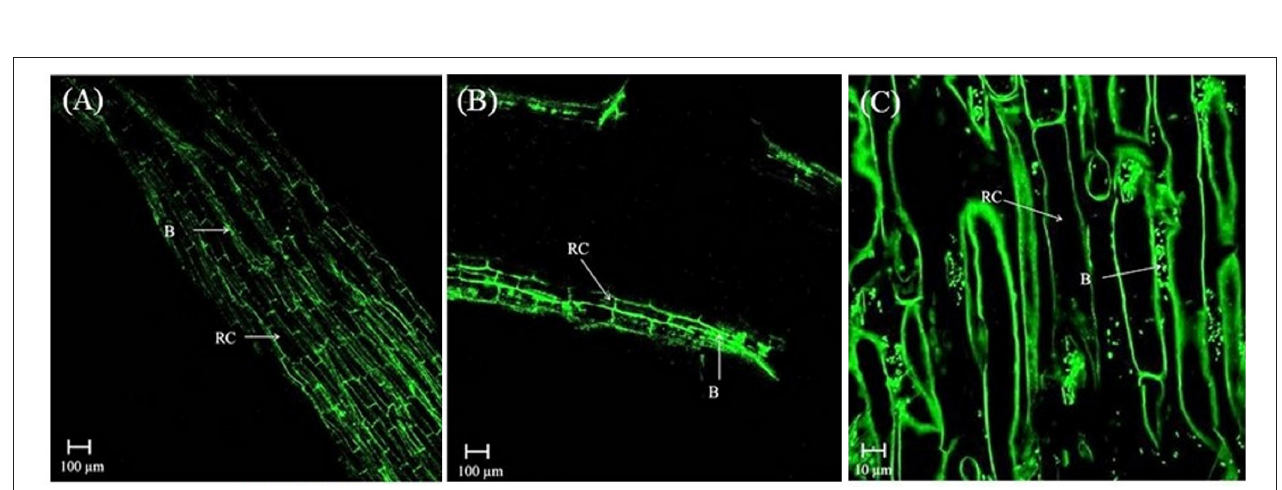
FIGURE 4 | Confocal microscopic image of potato root inoculated with YFP-labeled Azospirillum sp. TN03 in sterilized sand after 25 days. Lateral and primary roots of potato are ideal colonization sites of Azospirillum sp. TN03 (A,B) . Bacterial aggregates forming macro-colonies were observed on root epidermal cells validating association of TN03 strain with potato roots (C) . RC, Root cell; B, Bacterium.